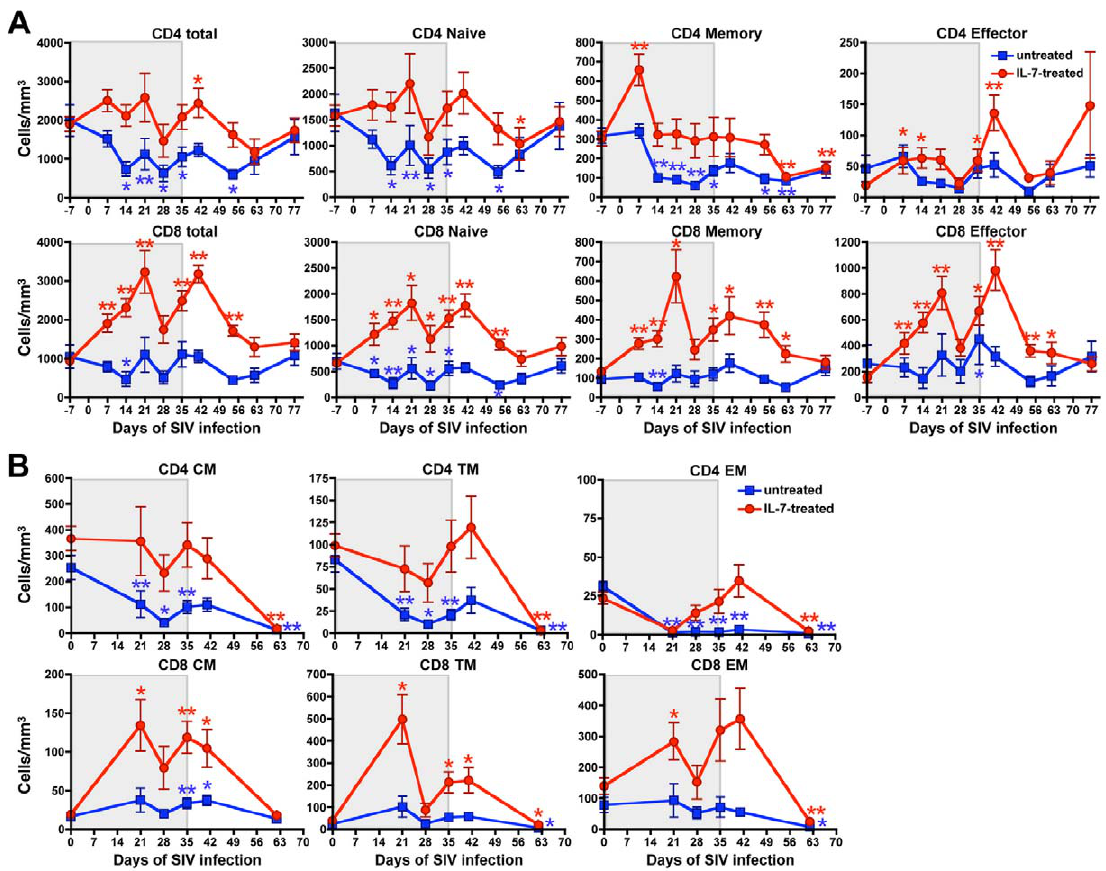
Figure 3. Effect of IL-7-treatment on peripheral blood T-lymphocyte kinetics. (A) Mean absolute numbers ( 6 SEM) of circulating total, naı¨ve, memory and effector CD4 + and CD8 + T cells in untreated (blue) and IL-7-treated (red) animals. The naı¨ve (CD28 + 95 2 ), memory (CD28 + 95 + ) and effector (CD28 2 95 + ) T-cell subsets were identified using a combination of mAbs against CD28 and CD95. (B) Subset analysis of memory CD4 + and CD8 + T cells in untreated (blue) and IL-7-treated (red) animals. The various memory T-cell subsets (central memory, CM; transitional memory, TM; and effector memory, EM) were identified using a combination of CD28, CD95, CD62L and CD197/CCR7. Absolute counts for each T-lymphocyte subpopulation were calculated by multiplying the percent values obtained by flow cytometry by the total lymphocyte counts obtained from the complete blood counts (CBC). The grey shaded area indicates the IL-7-treatment period; blue and red asterisks denote significant differences versus baseline values in untreated and IL-7-treated animals, respectively (* p , 0.05, ** p , 0.01, by paired Student’s t